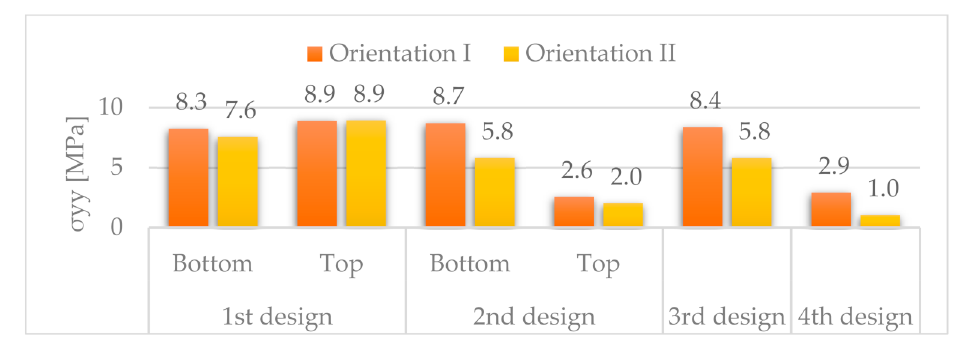
Figure 30. Stresses σ yy . Table 4. Comparative results for the best configurations found for each design, for α = 80 ◦ .